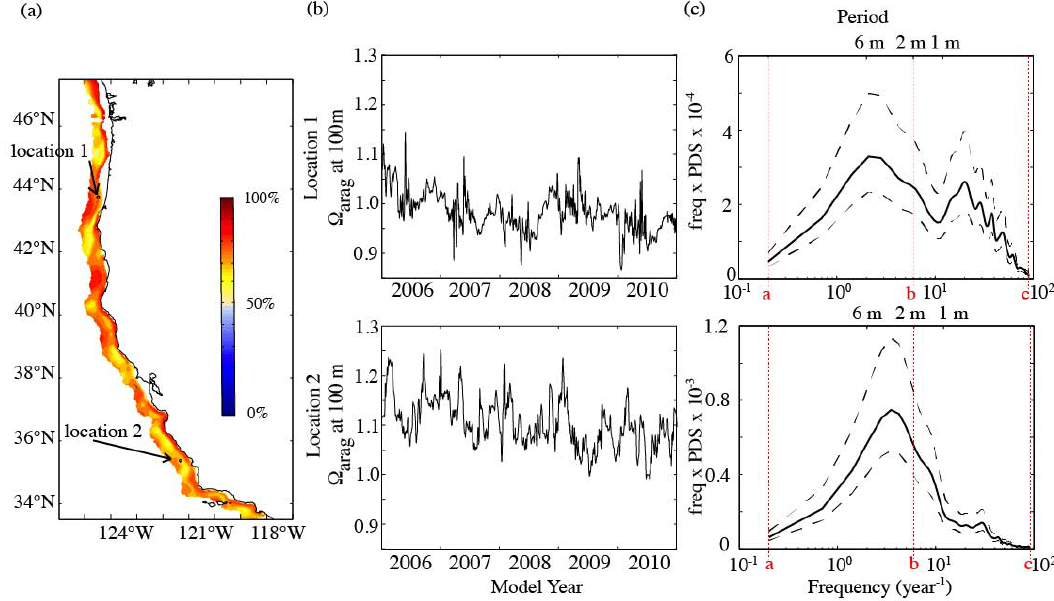
Fig. 3. Analysis of variability of (cid:127) arag at 100m. (a) indicates the percentage of the total variability of (cid:127) arag at 100m that occurs at frequencies less than b = 6yr − 1 . The arrows point out the locations of the two example sites described in panels (b) and (c) . (b) Time series of (cid:127) arag at 100m over 5yr for two distinct example locations and (c) a variance-conserving plot of the frequency × power density spectrum (PDS) vs. the frequency of the Fourier transformed time series. The black solid line represents the PDS and the black dashed lines envelope the ± 95% confidence interval. The red dashed lines show the boundaries a , b and c of the integrals applied in Eq. (1).